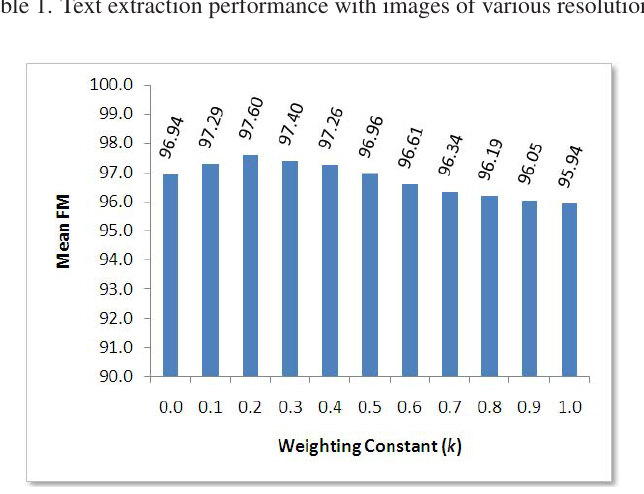
Table 1. Text extraction performance with images of various resolutions.